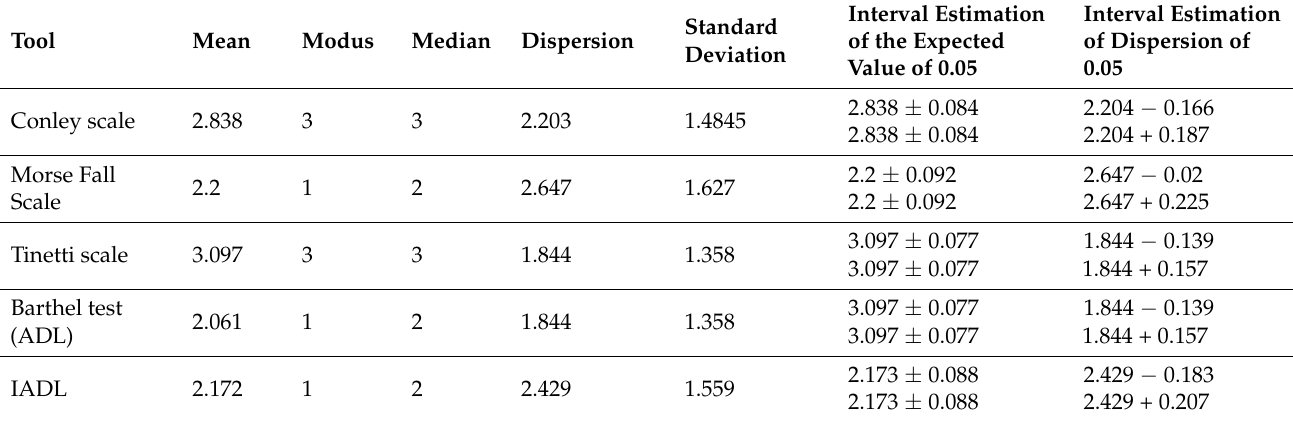
Table 2. Usability of standardized tools in the Czech